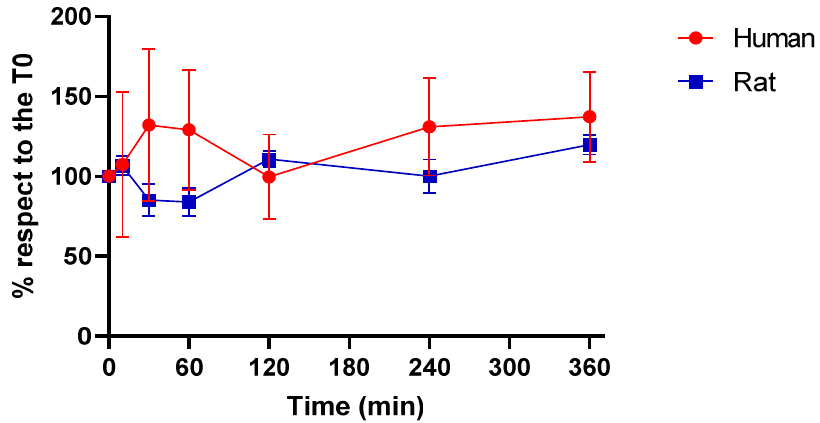
Figure 6. Rat and human plasma stability of JR22 : the compound was stable up to 360 min. Results are reported as mean relative % ± SD ( n =3).